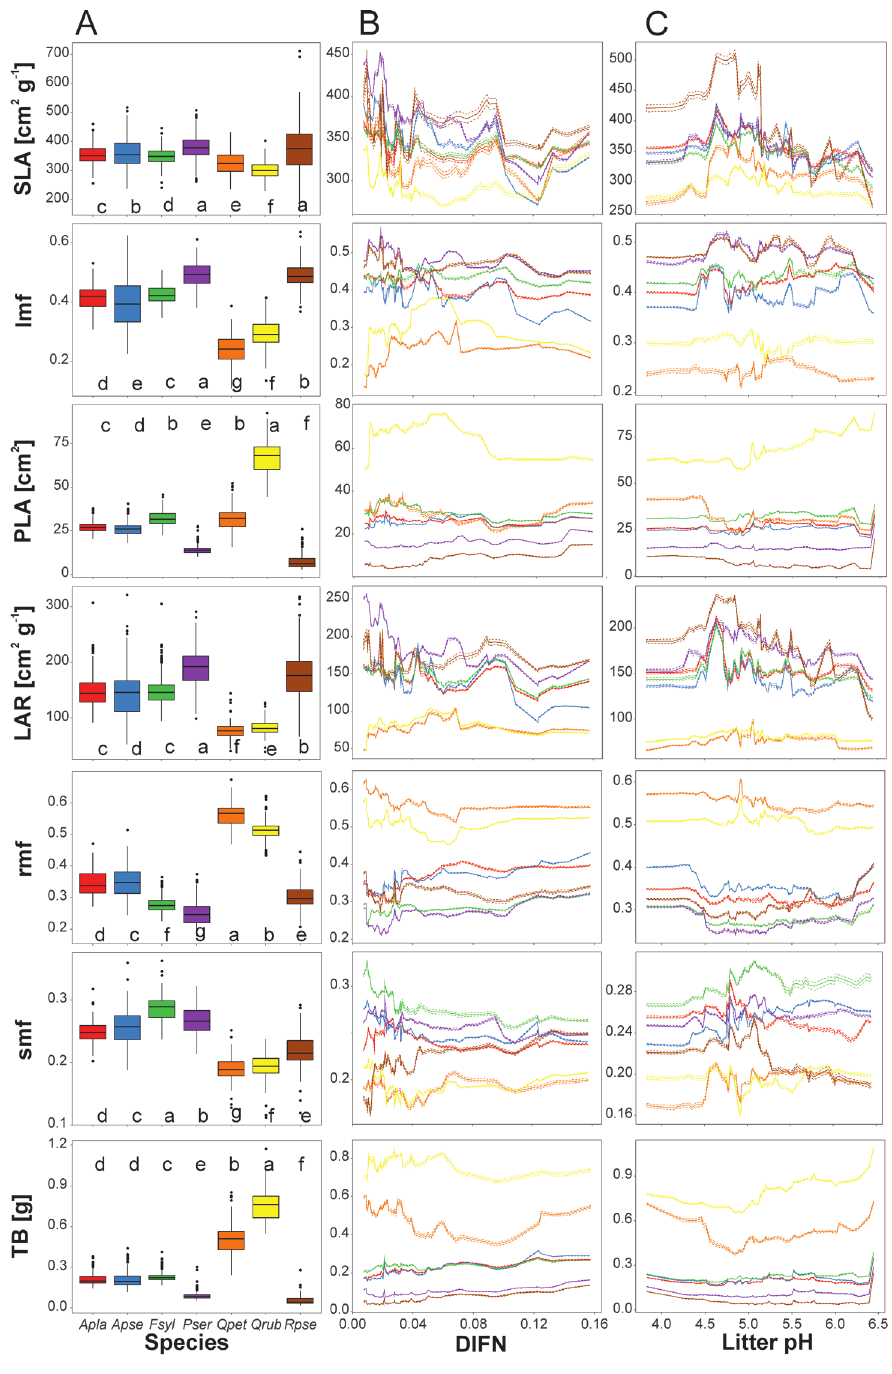
Figure 5. Seedlings traits variability of the species studied across predictors explained by a random forest model. For explanations see Fig.